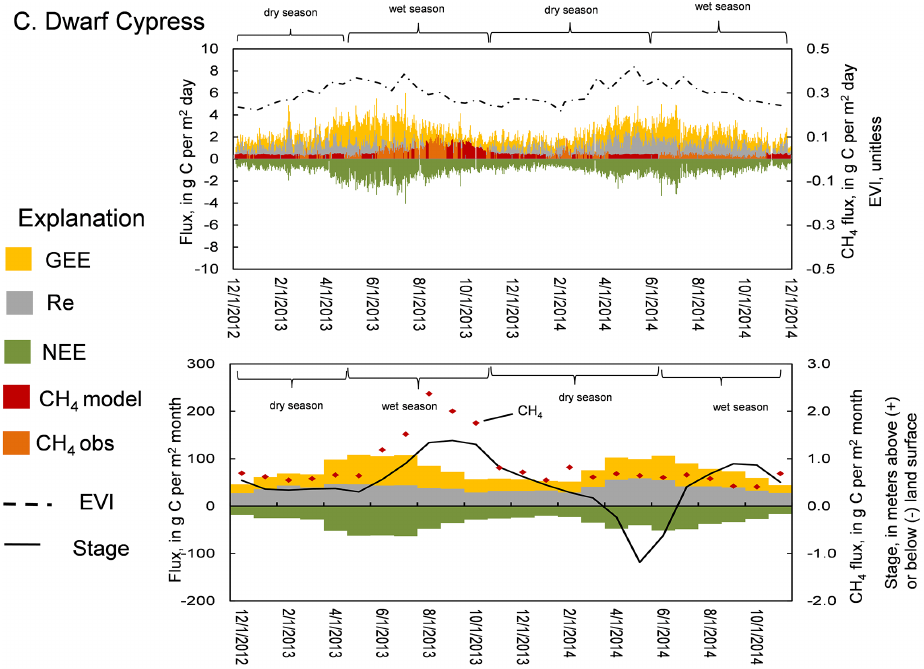
Figure 5. Daily and monthly C fluxes, stage and EVI at the (a) Pine Upland, (b) Cypress Swamp and (c) Dwarf Cypress sites. Dates are given in the format